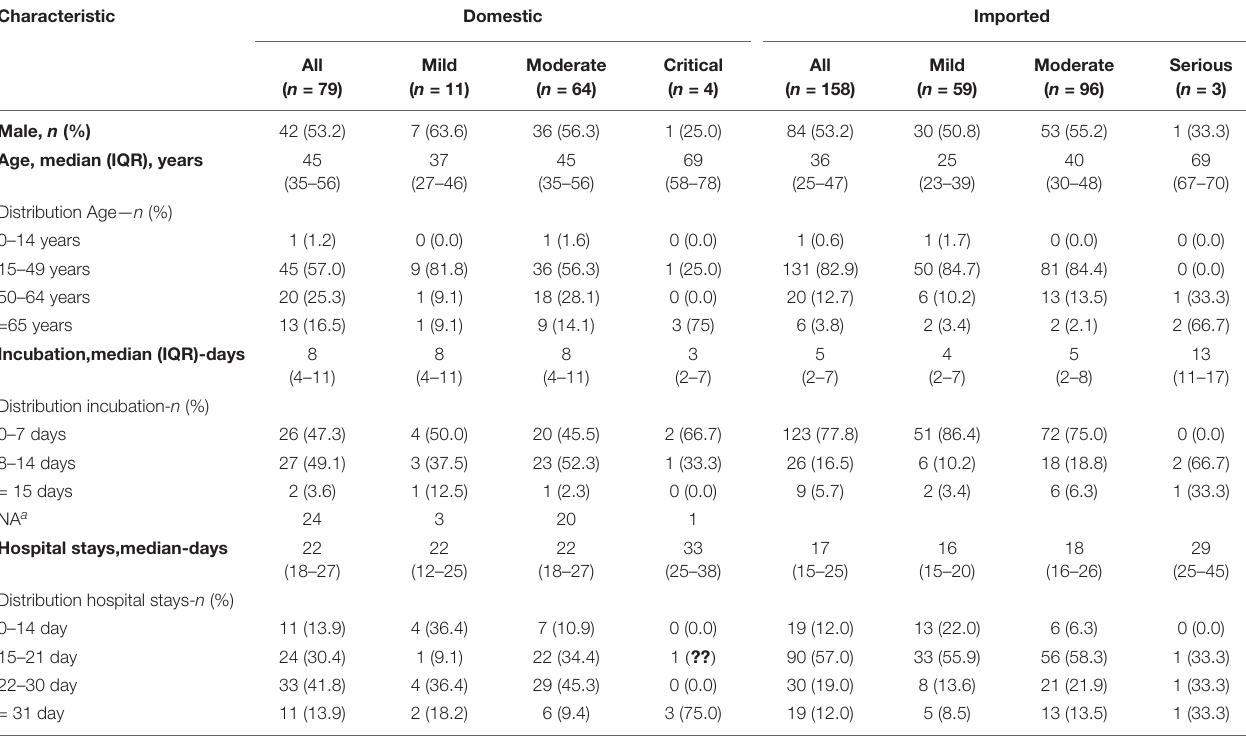
TABLE 1 | Demographic and clinical characteristics of domestic and imported patients with COVID-19 with different severity. Characteristic Domestic